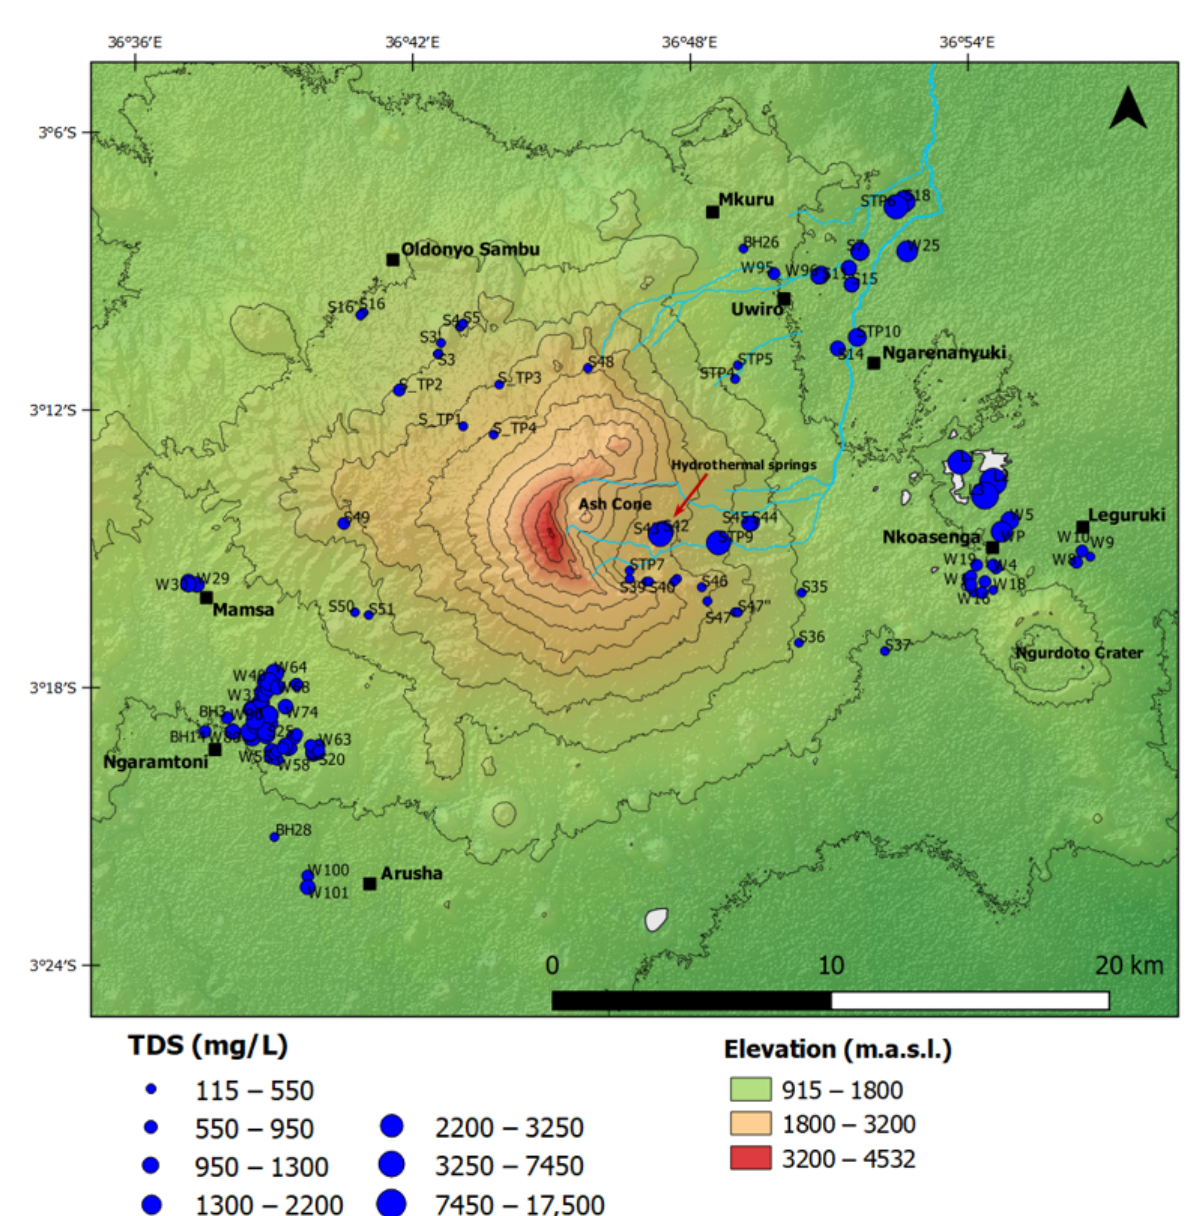
Figure 6. Spatial distribution of TDS in the study area with a clear increasing trend from the higher elevations towards the lower elevations (Labels: S, S_TP and STP—Spring (except STP9—Stream and STP10—River), W—Well, BH—Borehole, WP—Water pond, L—Lake).